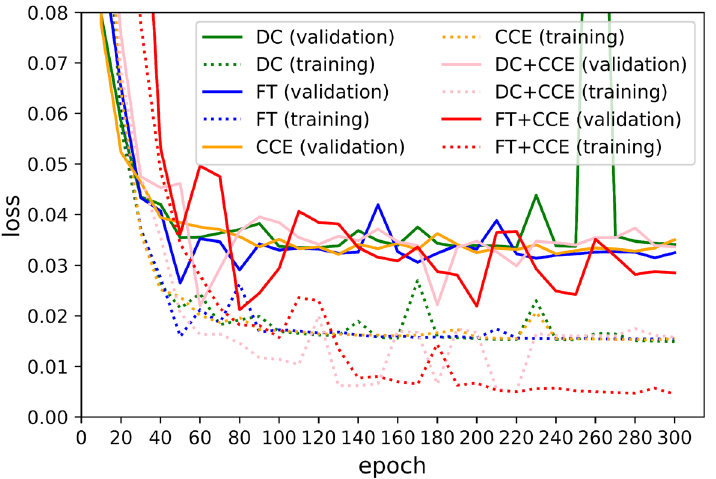
Figure 5. Progress of the training (dotted line) and validation loss (dotted line) with the number of epochs during training with DC (Green), FT (Blue), CCE (orange), DC plus CCE (pink), and FT plus CCE (red) loss functions,